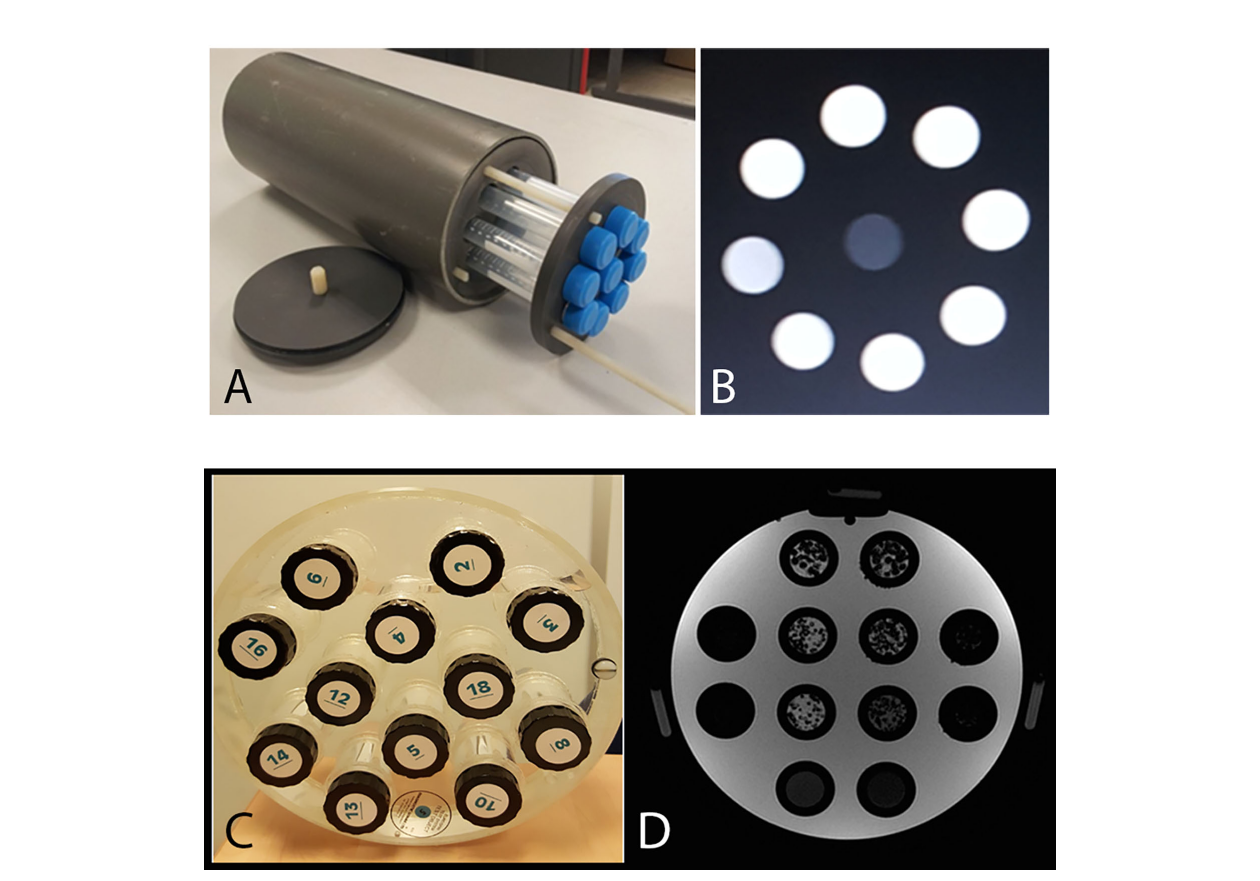
FIGURE 1 | (A) Homogeneous phantoms: eight 30-ml tubes fi lled with demineralized water mixed with increasing gadolinium chelate concentration (Gadoteric Acid; Dotarem ® , Guerbet): 0.25, 0.5, 0.75, 1, 1.25, 1.5, 1.75 and 2 mmol/l and a central demineralized water tube. (B) T1 weighted MRI image of the homogeneous phantom (256x256 matrix, 18 cm FOV). (C, D) T1 weighted MRI image of the heterogeneous phantom (256;256 matrix, 24 cm FOV): in the two central columns are six 30-ml tubes fi lled with polystyrene beads of different diameters (1, 2 and 3 mm) in an agarose gel solution (2%), either pure or mixed with 0.25 mmol/l gadolinium chelate, and two 30-ml tubes fi lled with agarose gel solution (2%) and two different concentration of gadolinium